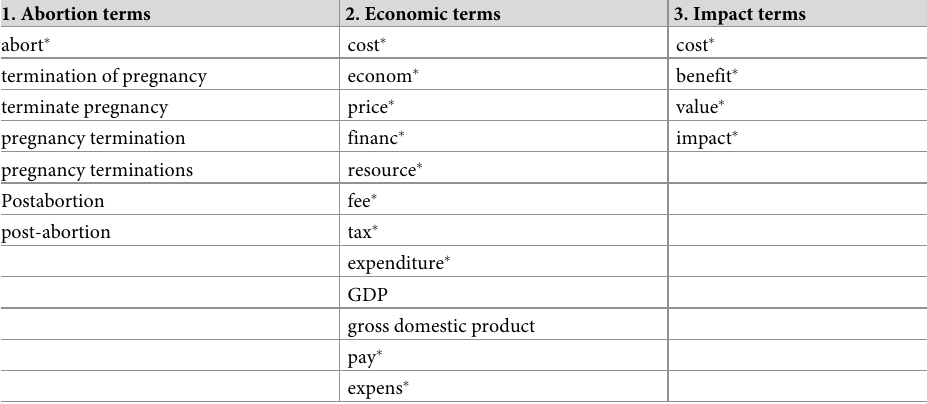
Table 2. Search terms and their